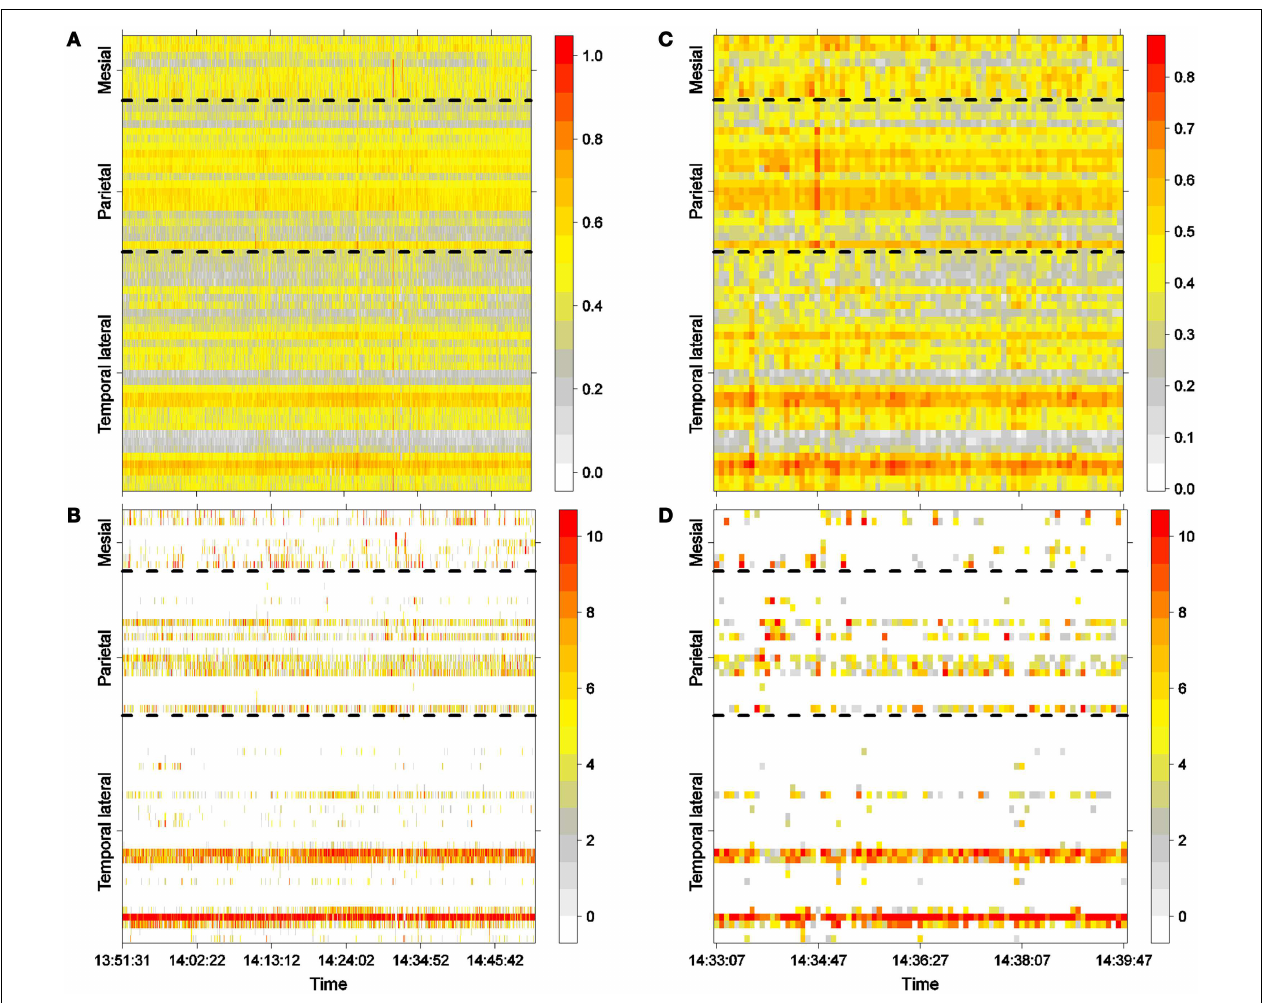
FIGURE 2 | Interictal activity . (A) One hour of LS activity in each electrode (Eq. 2). (B) LS ordering. One hour of the 10 most active areas (greatest is 10). (C) Six minutes of LS activity in each electrode (Eq. 2). (D) LS ordering 6min of the 10 most active areas (greatest is 10).